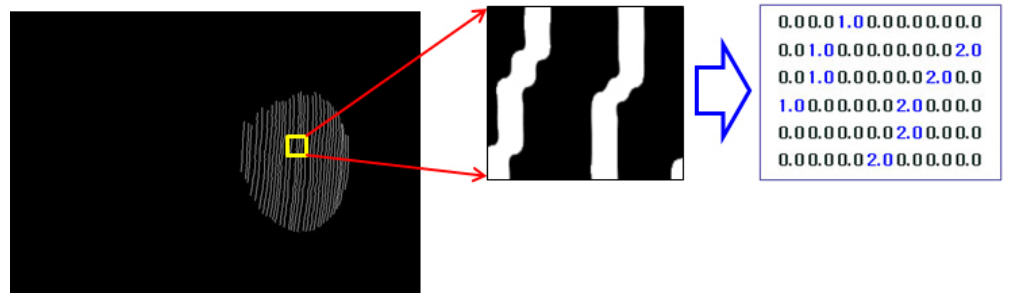
Figure 7. Code generation of thinned